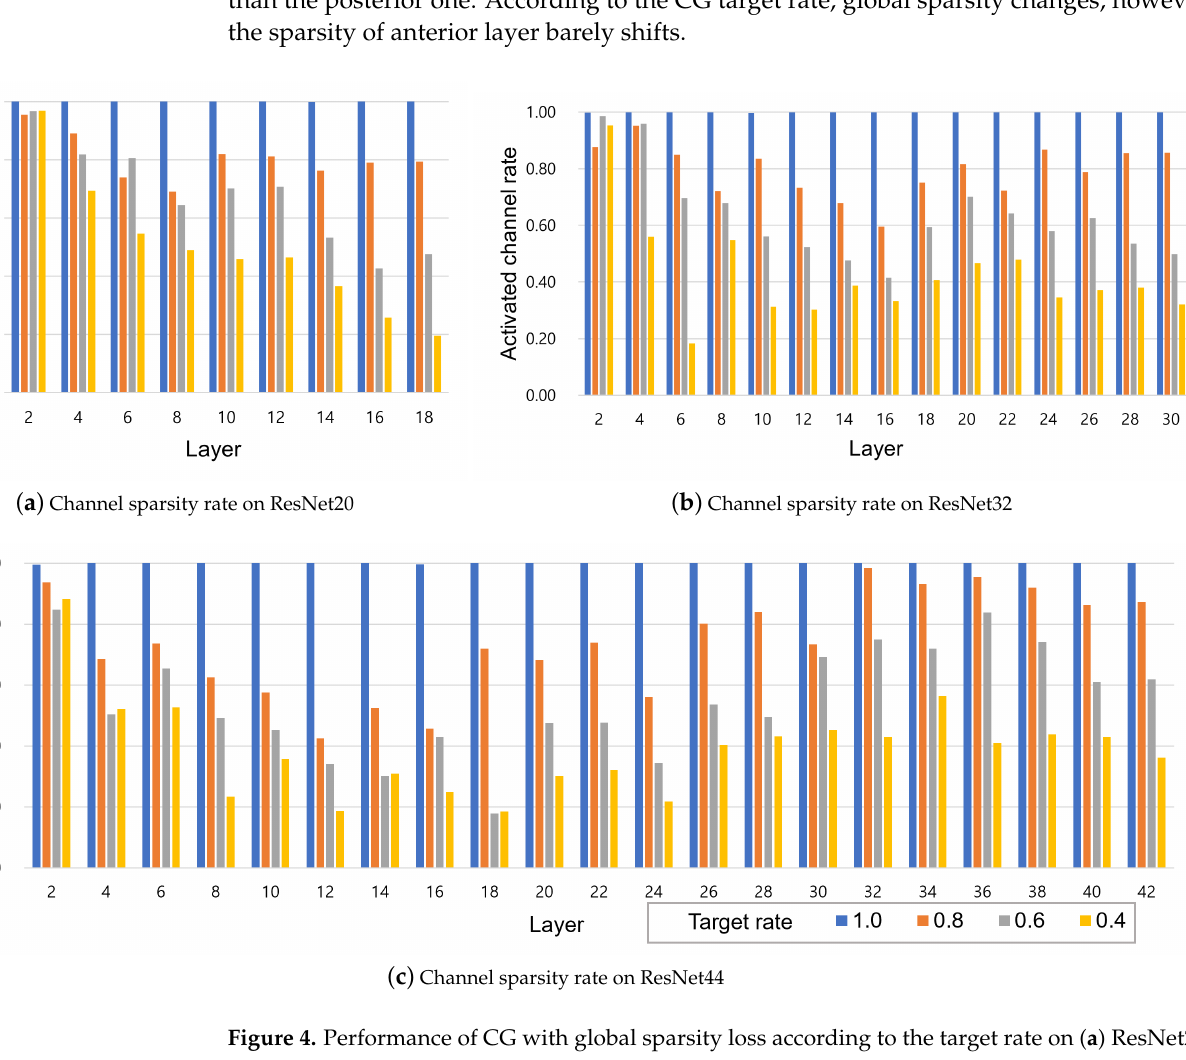
Figure 4. Performance of CG with global sparsity loss according to the target rate on ( a ) ResNet20, ( b ) ResNet32, and ( c ) ResNet44